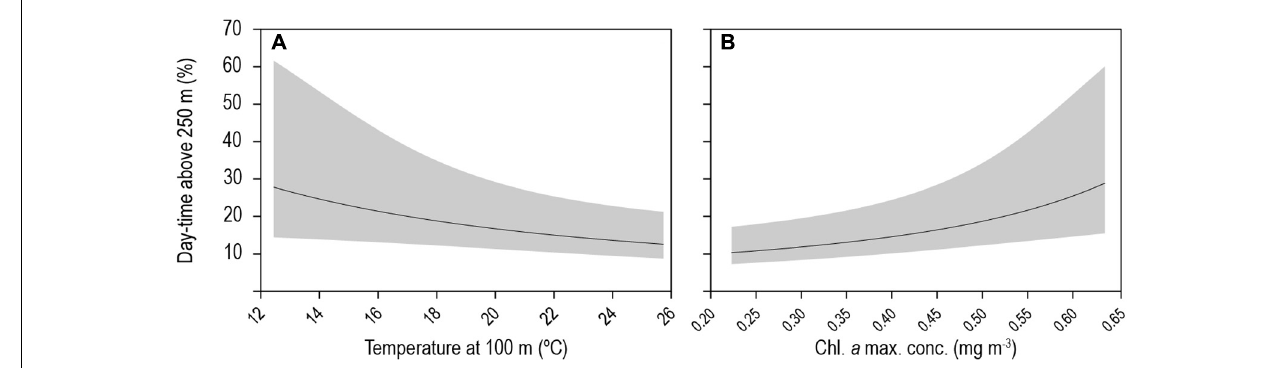
FIGURE 6 | Generalised linear mixed model (GLMM) relationships between blue shark day-time occupancy above 250 m depth and environmental variables. GLMM predicted probabilities of depth-use along (A) temperature at depth (100 m) and (B) concentration of the chlorophyll a maximum. Continuous lines represent mean predicted values for the species and shaded areas represent the 95% confidence intervals.